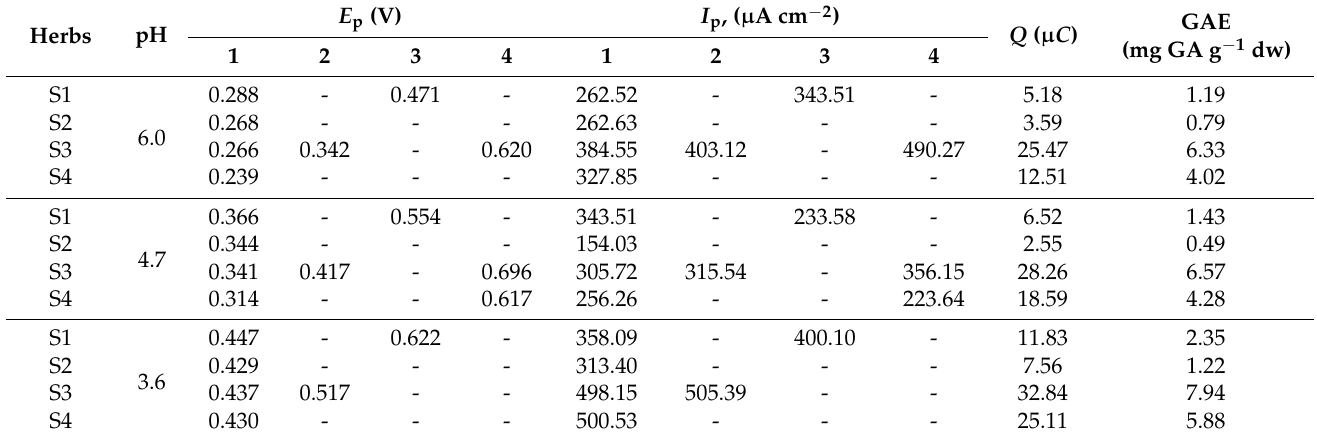
Table 1. Peak potentials, Ep, and currents, Ip, from cyclic voltammograms of aqueous plant extract